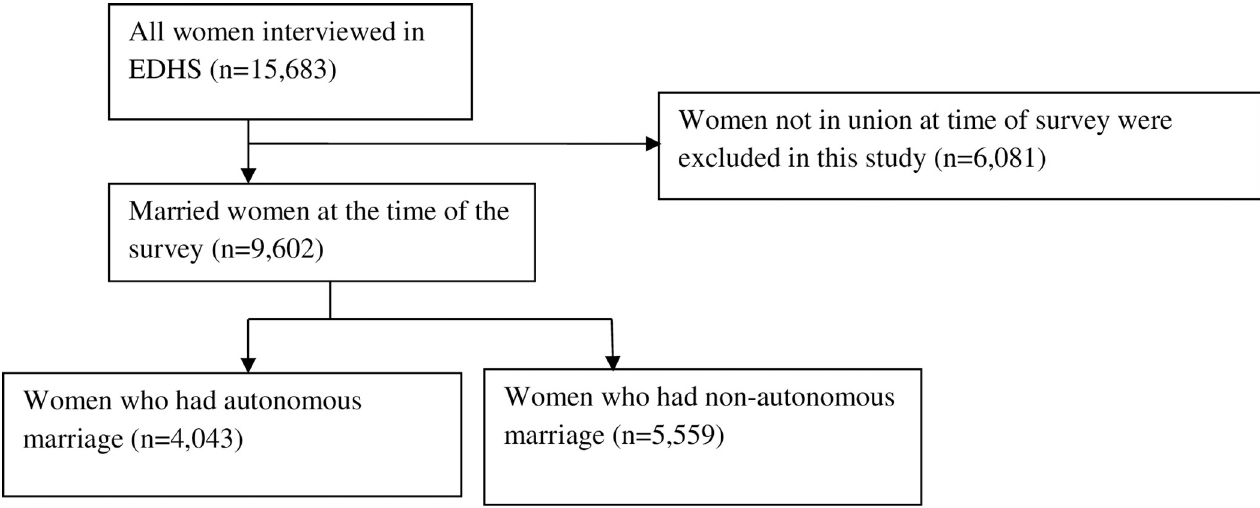
Fig 1. Flow chart showing the weighted sample used in the study was derived.